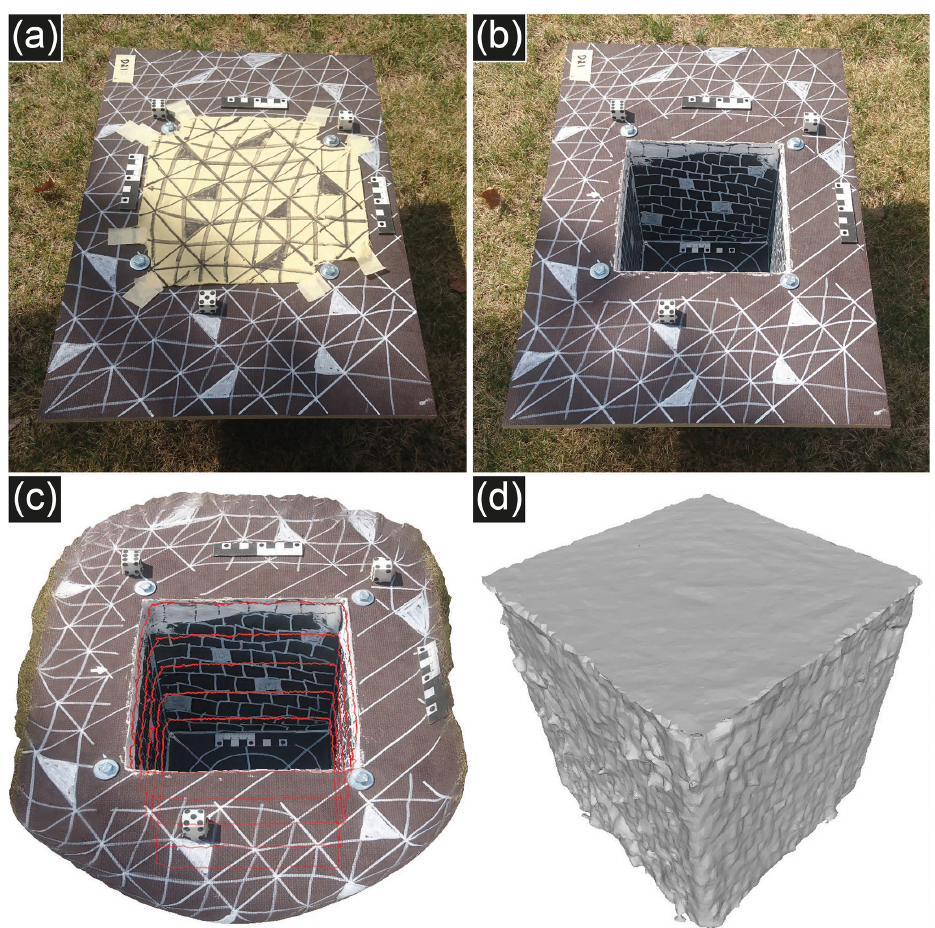
Figure 3. The flowerpot with a board attached (D21) with (a) and without (b) the thin fabric covering the opening. The reconstructed artificial pit is shown with 5cm contours in red (c) . To obtain the final watertight mesh, the reconstructions of simulated pre-dug surface and soil pit were merged by bridging the edges of the two meshes (d)